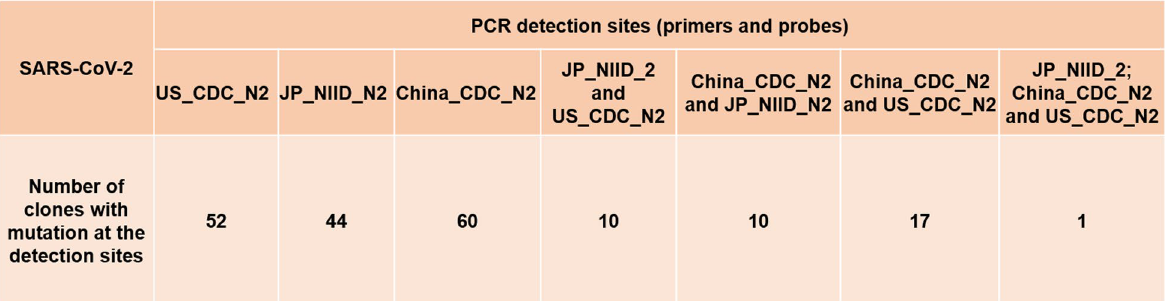
Table 1 The number of global samples identified with the mutation at the primer-probe binding sites for RT-PCR-based detection of severe acute respiratory syndrome coronavirus 2